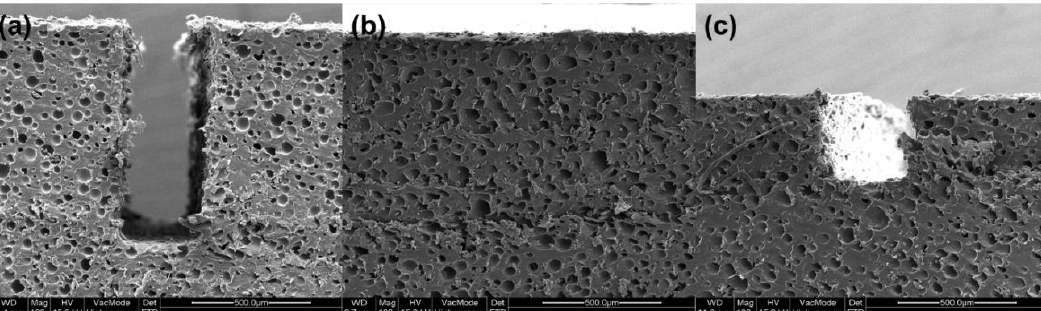
Figure 17. Scanning electron microscope (SEM) images of the cross-sections of polishing pads in the wafer–pad contact area: ( a ) as-received, ( b ) after conditioning for Case I, and ( c ) after conditioning for Case II.